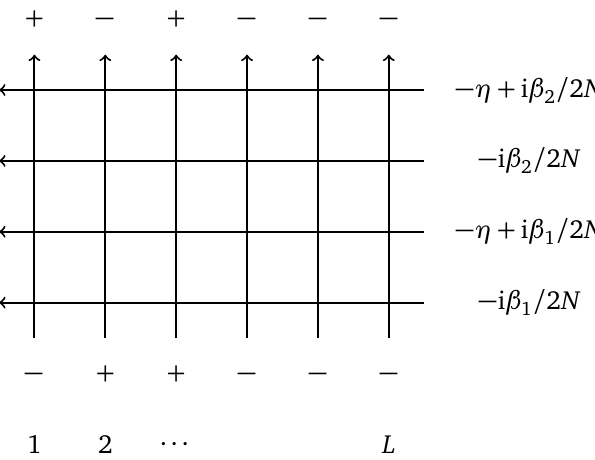
Figure 2: An example for the partition function (4.10) with L = 6 and N = 2, de- scribing the matrix element (4.15). We have periodic boundary conditions in the horizontal direction, and the bottom and top rows are fixed by the initial and final states in the spin